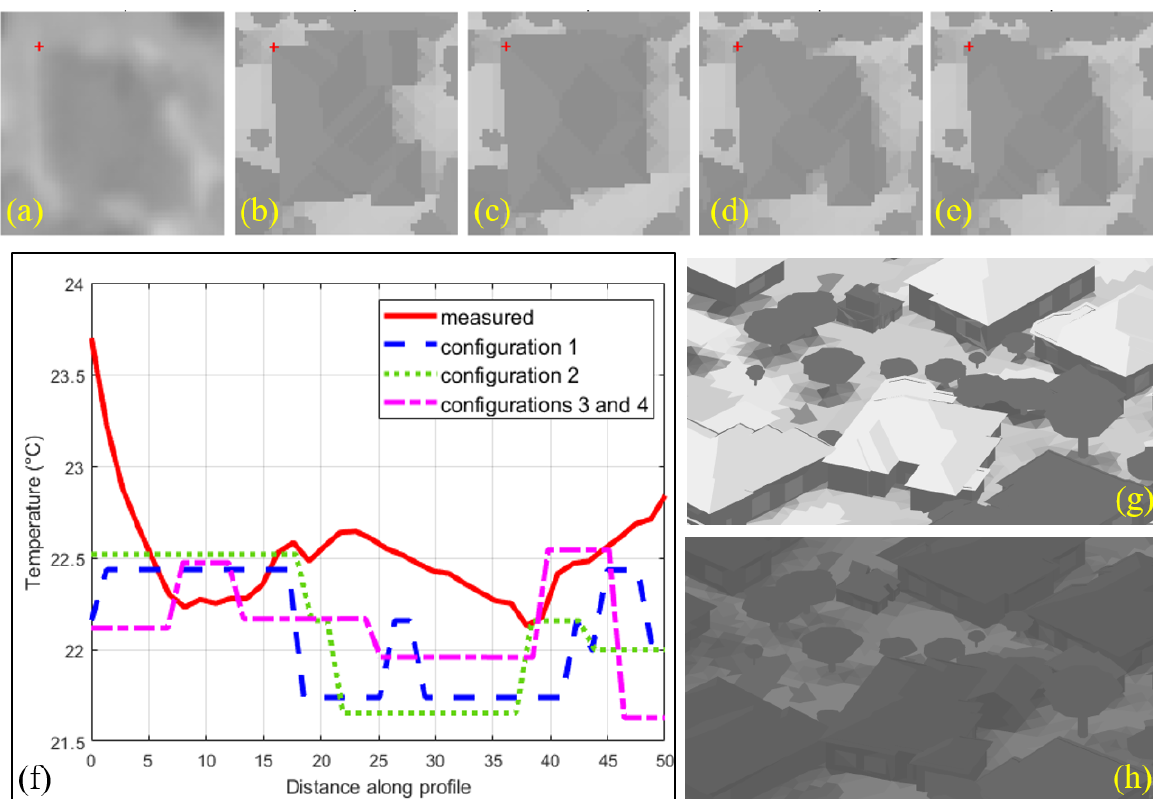
Figure 5. Temperature distribution in the (a) thermal image around a single building: Images (b) to (e) show the corresponding distributions resulting from configurations 1 to 4, respectively. Image (f) shows the corresponding temperature profiles along the line connecting the left upper and right lower corner of the building in the measured thermal image and the four configurations, respectively. The building itself (configuration 1, at 2 pm and 8 pm) is depicted in images (g) and (h). Note that the output for configurations 3 and 4 results in the same building